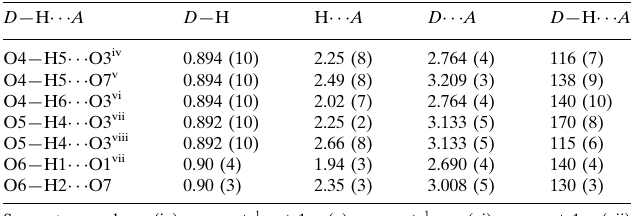
Hydrogen-bond geometry (A˚ , (cid:4)